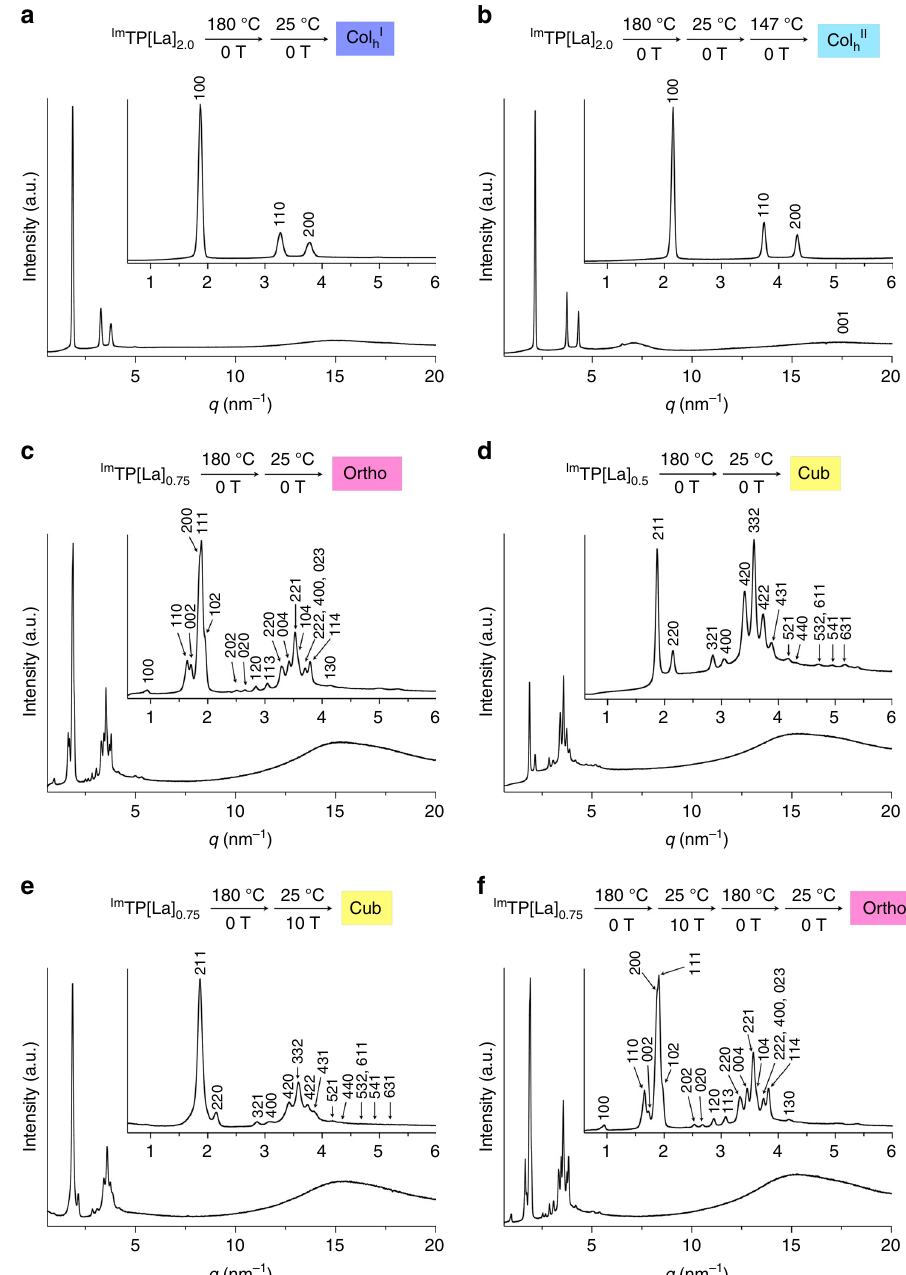
Fig. 2 Powder X-ray diffraction (PXRD) patterns of bulk samples of Im TP[La] x . a – f PXRD patterns and magni fi cations of the small-angle region (scattering vector q = 0.6 – 6 nm − 1 ) of Im TP[La] 2.0 at 27 °C on fi rst heating ( a ), Im TP[La] 2.0 at 147 °C on fi rst heating ( b ), Im TP[La] 0.75 at 27 °C on fi rst heating ( c ), fi rst heating ( d ), Im TP[La] fi rst heating after thermal processing in a 10-T magnetic fi eld ( e ) and Im TP[La] Im TP[La] 0.5 at 27 °C on 0.75 at 27 °C on 0.75 at 27 ° C after thermal processing in a 10-T magnetic fi eld, followed by thermal processing in the absence of a magnetic fi eld ( f ). Prior to the measurements, the samples in ( a – d ) were heated once to 180 °C in the absence of a magnetic fi eld. The samples in ( e , f ) were heated once to 180 °C in the absence of a magnetic fi eld, and subsequently cooled to 25 °C (cooling rate ≤ 0.5 °C/min) in a 10-T magnetic fi eld. Cub cubic, Ortho orthorhombic, Col h hexagonal columnar, a.u. arbitrary unit. Indices of the re fl ections are shown in the magni fi cations of the PXRD patterns increased, resulting in an intensity ratio of 5.0 at 27 °C (Fig. 3f), two peaks ( √ 6: √ 8) agrees well with that expected for re fl ections ̄ which is virtually identical to that observed for the magnetically 211 and 220 of the Ia 3 d cubic structure, their intensity ratio is induced Cub phase of Im TP[La] 0.75 (4.8; Fig. 2e). Therefore, in the different from that observed for the magnetically induced Cub 7 T magnetic fi eld, the Cub phase of Im TP[La] 0.75 starts to emerge phase of Im TP[La] 0.75 (Fig. 2e). The observed X-ray diffraction peaks can be explained by considering the coexistence of the from the Col h II phase at ~160 °C and develops over the entire material at 27 °C. The diffraction peaks of the Cub phase persisted Col h II and Cub phases at 157 °C in the presence of the magnetic fi eld. Importantly, upon further cooling to 27 °C, the intensity of stably at 27 °C even after the magnetic fi eld intensity was decreased to 0.0 T (Fig. 3g). However, in a second heating and the stronger peak decreased, whereas that of the weaker peak NATURE COMMUNICATIONS| (2018) 9:4431 |DOI: